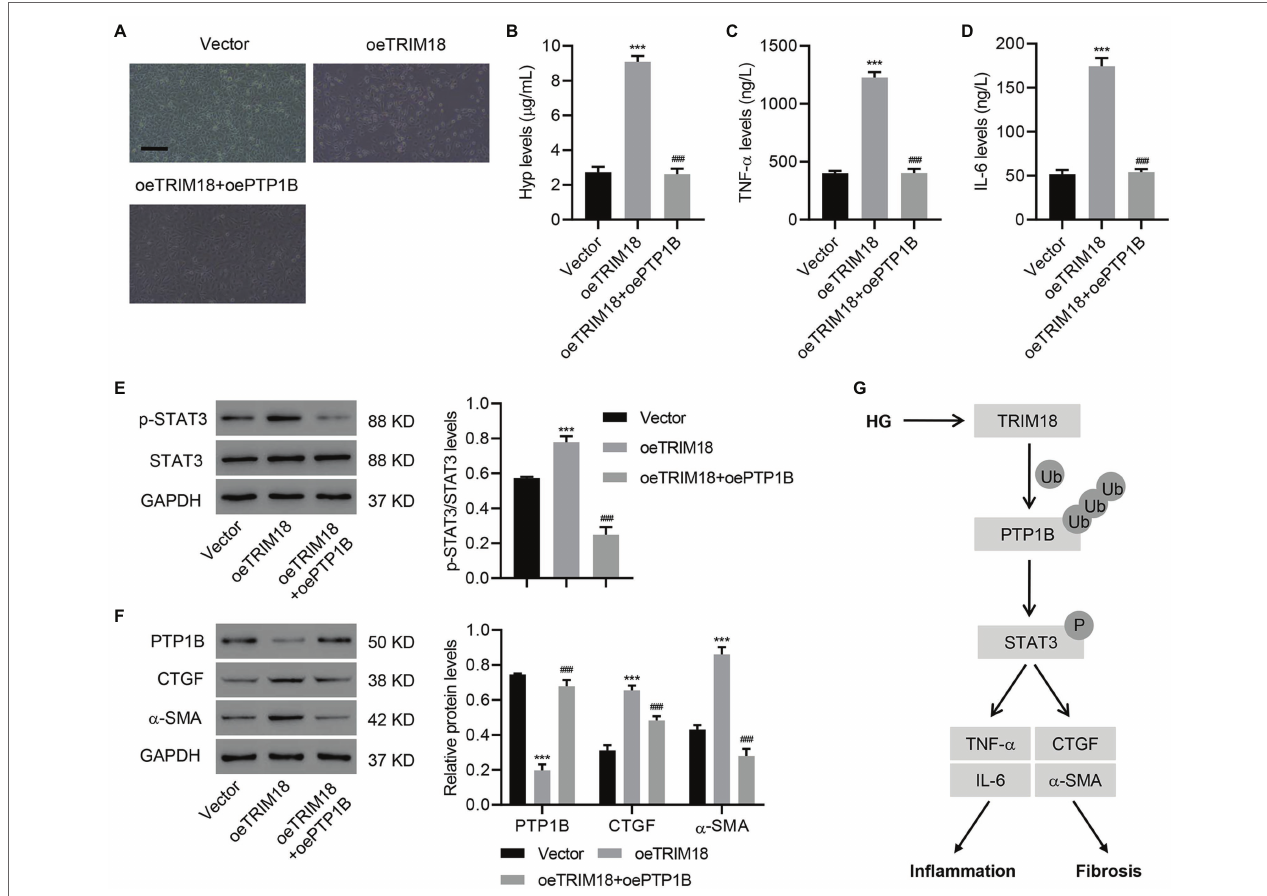
FIGURE 6 | TRIM18-regulated STAT3 signaling pathway via PTP1B promotes renal EMT, inflammation, and fibrosis. HK-2 cells were transduced with the indicated vectors, and the (A) cell morphology, (B–D) levels of Hyp, IL-6, and TNF- α , and (E,F) expression of p-STAT3, PTP1B, CTGF, and α -SMA were measured. Scale bar: 100 μ m. (G) Schematic representation of the regulation of inflammation and fibrosis of HG-induced HK-2 cells via the TRIM18/PTP1B/STAT3 pathway. Values are presented as mean ± SD. n = 3/group. *** p < 0.001 vs. vector. ### p < 0.001 vs.